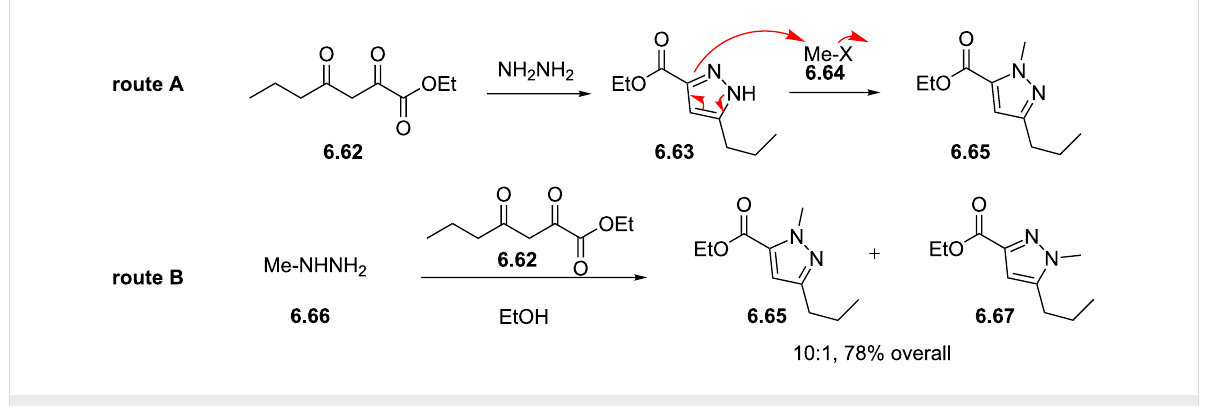
a solution of methylhydrazine in ethanol. If the order of